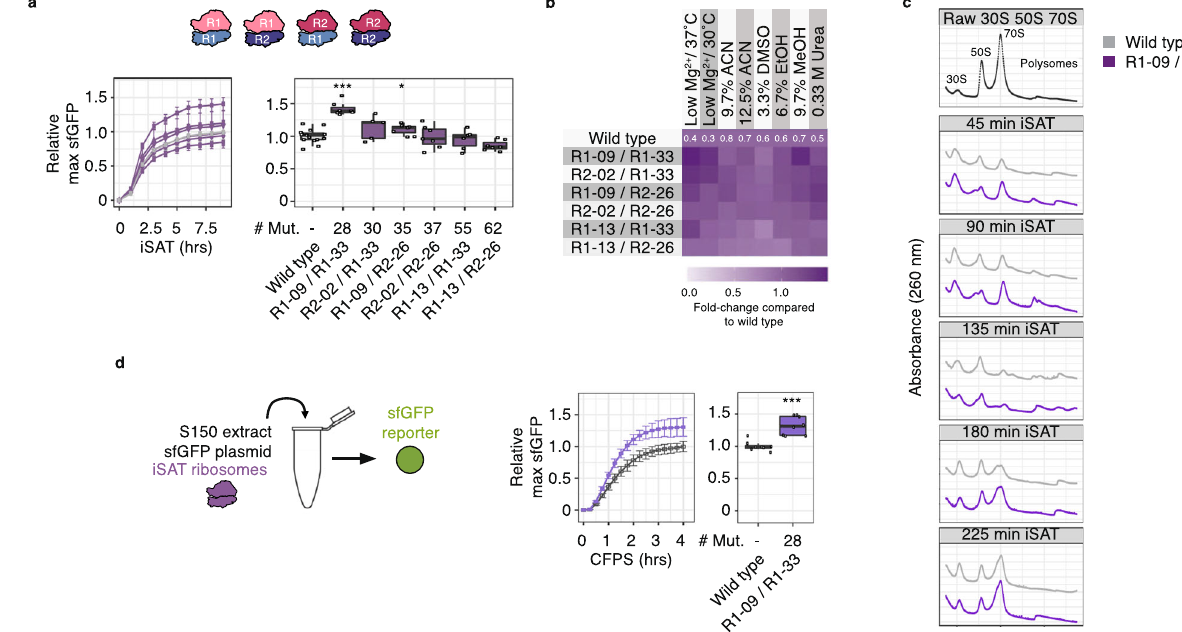
Fig. 4 | Eterna ribosomes confer bene fi cial phenotypes in vitro. Two 23S rRNA designs and three 16S rRNA designs with tolerant iSAT stress phenotypes were combined and tested in iSAT under various conditions: a optimal conditions, or b stress conditions. sfGFP expression in iSAT was determined by fl uorescence and normalized to the maximum sfGFP of pT7-rrnB-wild type at optimal iSAT condi- tions. Fold changes in b illustrate iSAT activities normalized to wild type perfor- mance under solvent conditions. c Assembly of wild type and R1 – 09/R1-33